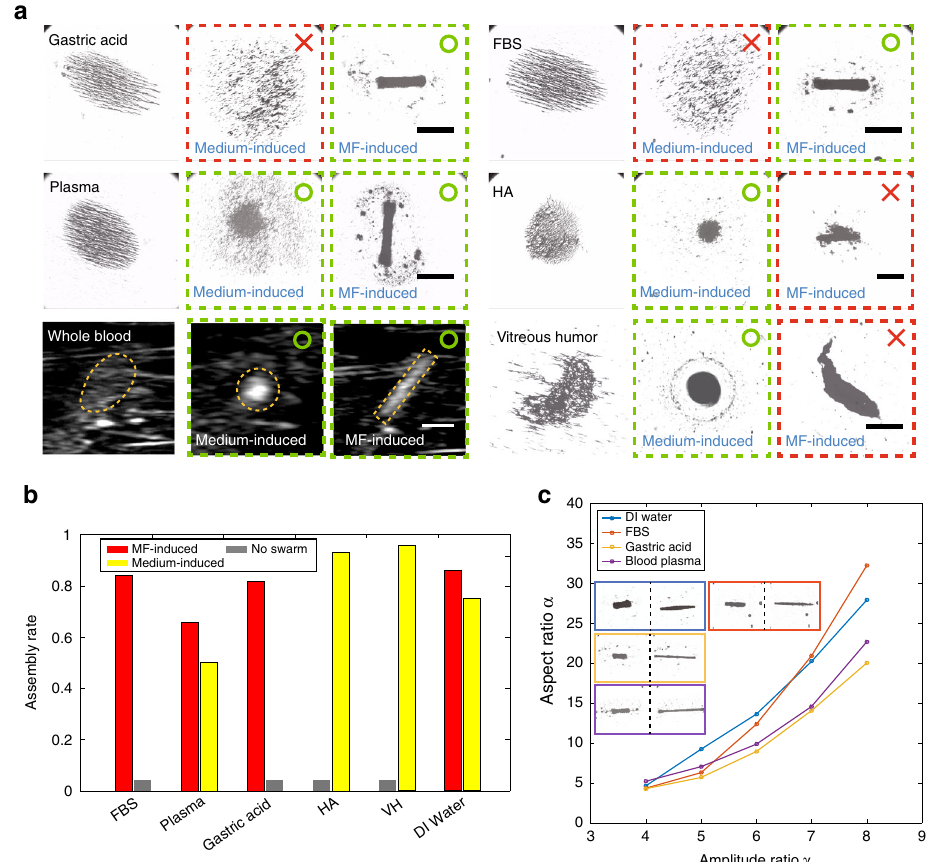
Fig. 4 Experimental validations for the prediction. a The generation processes of the medium-induced and the MF-induced swarms in gastric acid, FBS, plasma, HA, whole blood and vitreous humour, respectively. Because the red blood cells in whole blood block most of the light from an optical microscopy, ultrasound imaging is applied for the observation. The scales bars represent 800 μ m. b The assembly rate, which indicates the percentage of swarm central area after the generation process in different bio- fl uids. c The relationship between the aspect ratio of the MF-induced swarms and the input amplitude ratio. Demonstrations of the elongation of the ribbon-like swarms in DI water, FBS, gastric acid and blood plasma are presented in the insets with blue, red, yellow and purple rectangles,